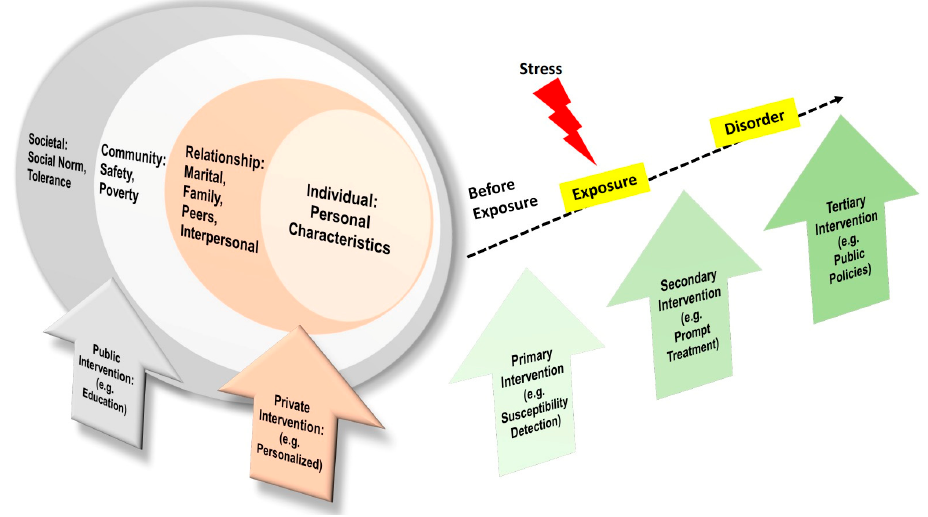
Figure 3. Social-ecological model for traumatic stress and related preventive interventions.